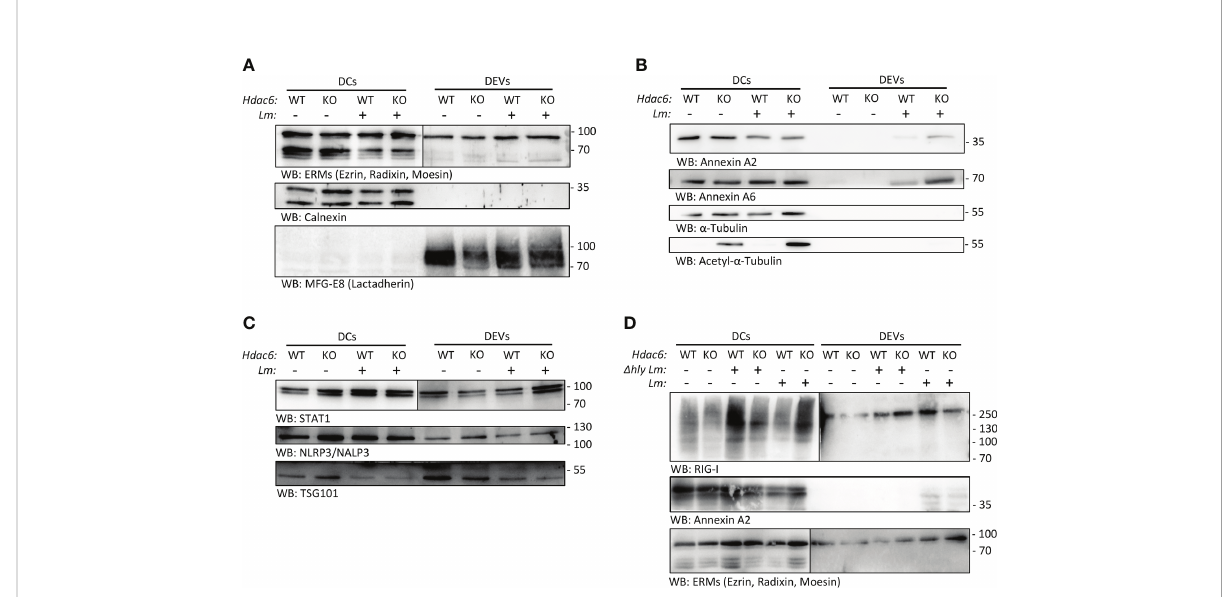
FIGURE 3 Lm infection skews protein content of BMDC-secreted EVs. (A, B) Western blot analysis of protein extracts prepared from total lysates from Lm- infected or non-infected Hdac6 +/+ (WT) or Hdac6 - /- (KO) DCs and their respective secreted EVs (16 hpi). Cells and EVs were blotted for EV markers (ERMs and MFG-E8/Lactadherin) and an endoplasmic reticulum control (Calnexin) in A. Top right (DEVs, ERMs) is shown at a longer exposure time. In B, an analysis of Annexin A2 Annexin A6, Tubulin and acetylated tubulin is included being the sample the sample the same as in A. (C) Western blot analysis of STAT1, NLRP3/NALP3 and the EV marker TSG101 in DEVs samples from WT and KO-BMDCs infected or not with Lm . DEVs panel for STAT1 (on the right) is shown at a longer exposure time. (D) Western blot analysis of cells and EVs blotted